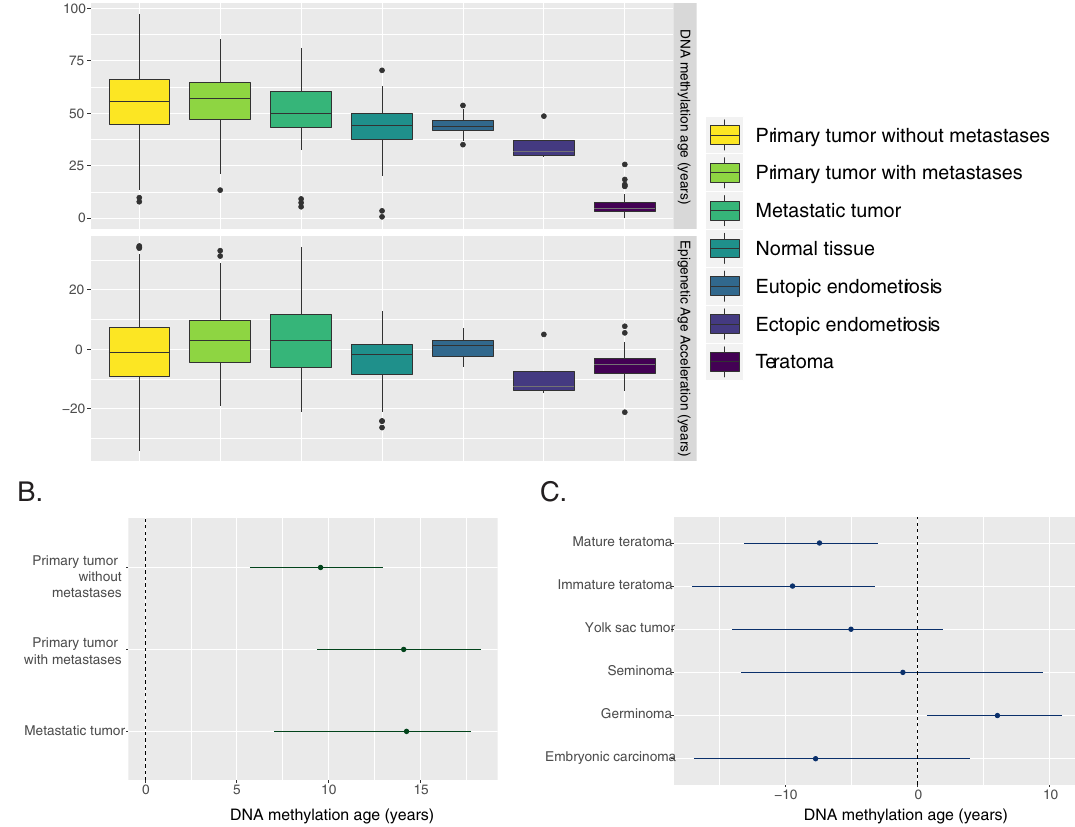
Figure 4. ( A ) Predicted DNA methylation age and epigenetic age acceleration by tissue type. Ectopic endometriotic tissue shows age deceleration comparable to that seen in teratomas. Primary tumor without metastases: n = 534; Primary tumor with metastases: n = 82; Metastatic tumor: n = 38; Normal: n = 81 (8); Eutopic endometriosis: n = 29 (3); Ectopic endometriosis: n = 7 (3); Teratoma: n = 25. Since EAA is dependent on knowledge of donor age, the samples for which the information about the age was absent were excluded from EAA analyses. These samples are given in parentheses. Limits of EAA plot exclude 23 outliers: 17 in